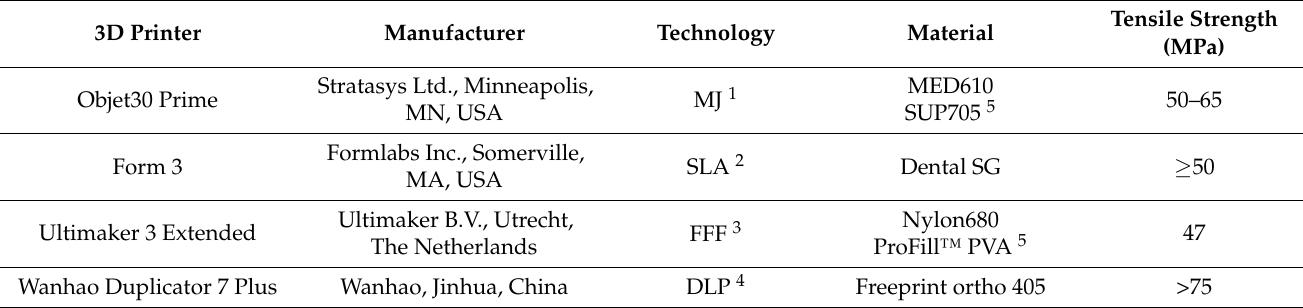
Table 2. 3D printers, printing technology, and material